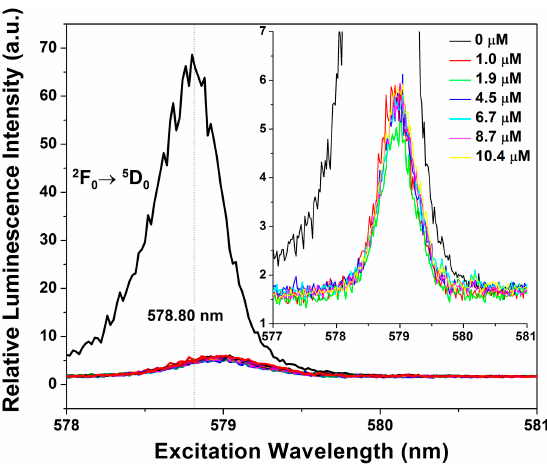
Figure 5. Excitation scan of the Eu 3+ transition, 2 F 0 → 5 D 0 , centered at a wavelength of 578.80 nm. The concentration of europium is 10 μ M, while junction is titrated in to reach the same concentration. Junction binding quenched the overall europium luminescence and produced a slight red-shift in the excitation peak to 579.00 nm. ( Inset ) Inset highlights the peaks from 1.0 to 10.4 μ M Eu 3+ , which are relatively narrow (fwhm = 1 nm) and uniform.